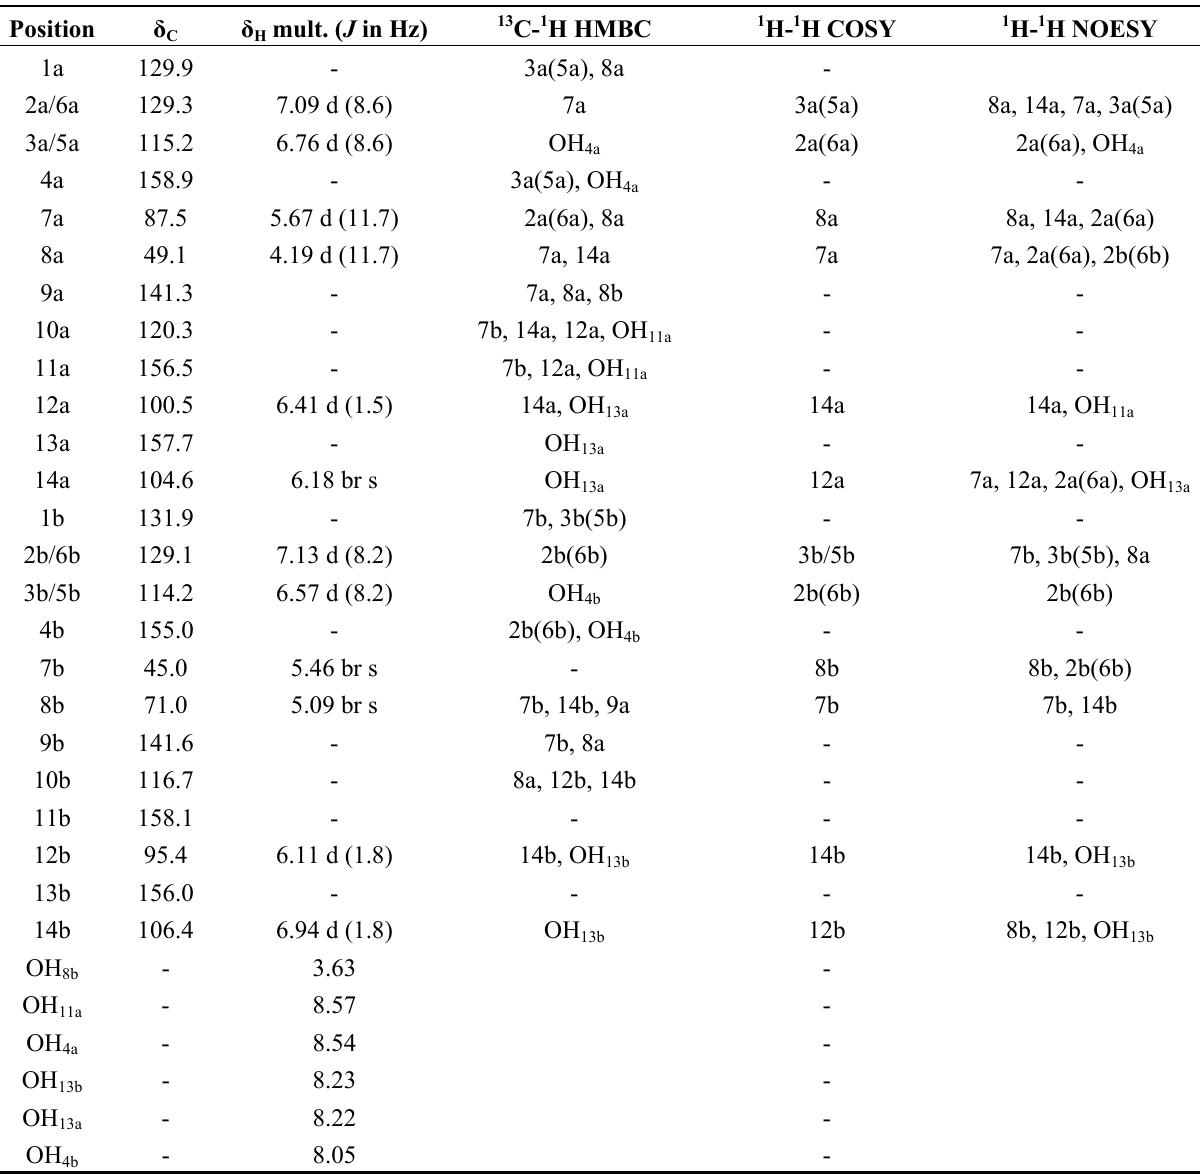
Table 1. 13 C- and 1 H-NMR spectral data * of 1